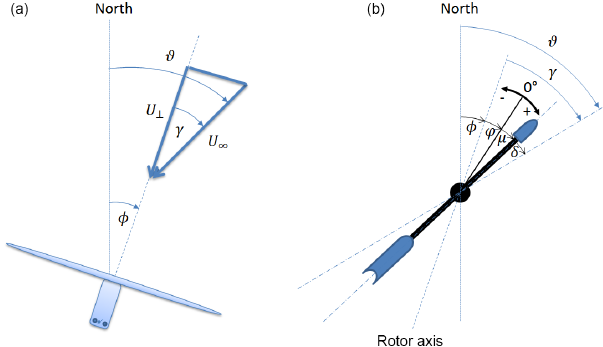
Figure 1. Definition of angles. (a) The angle between the rotor axis and the true north is called the nacelle position φ . The angle be- tween the true wind direction ( ϑ ) U ∞ and its component perpen- dicular to the rotor plane U ⊥ is denoted as yaw error γ . (b) The wind vane is located behind the rotor. Its assembly angle ϕ with re- spect to the rotor axis, the measured value µ and the flow deflection angle δ between the wind vane and true wind direction sum up to the yaw error γ .